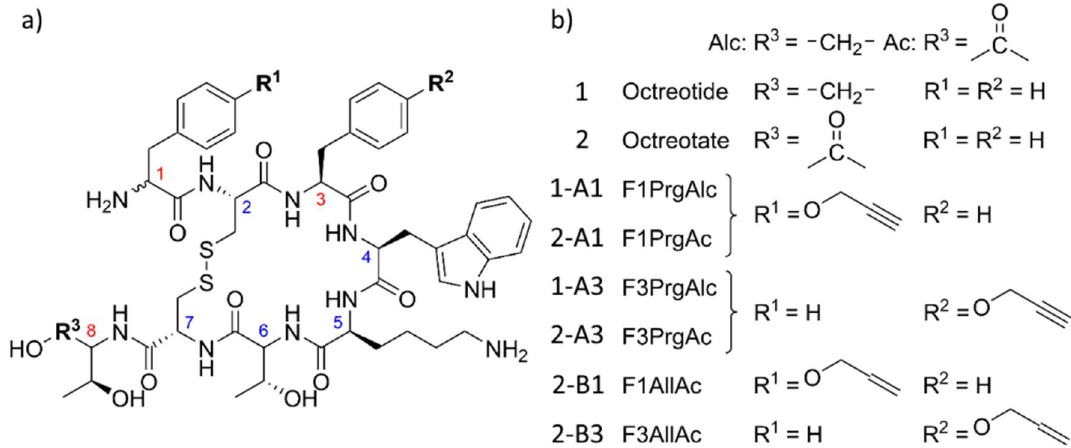
Figure 2. ( a ) General structures of octreotide ( 1 ) and octreotate ( 2 ) and its derivatives with a propargyl tyrosine ( A ) or allyl tyrosine ( B ) PHIP markers at position 1 (- A1, B1 ) or position 3 (- A3, B3 ). Compounds 2-B1 and 2-B3 represent the hydrogenation products of 2-A1 and 2-A3 . ( b ) Structure of labels and corresponding